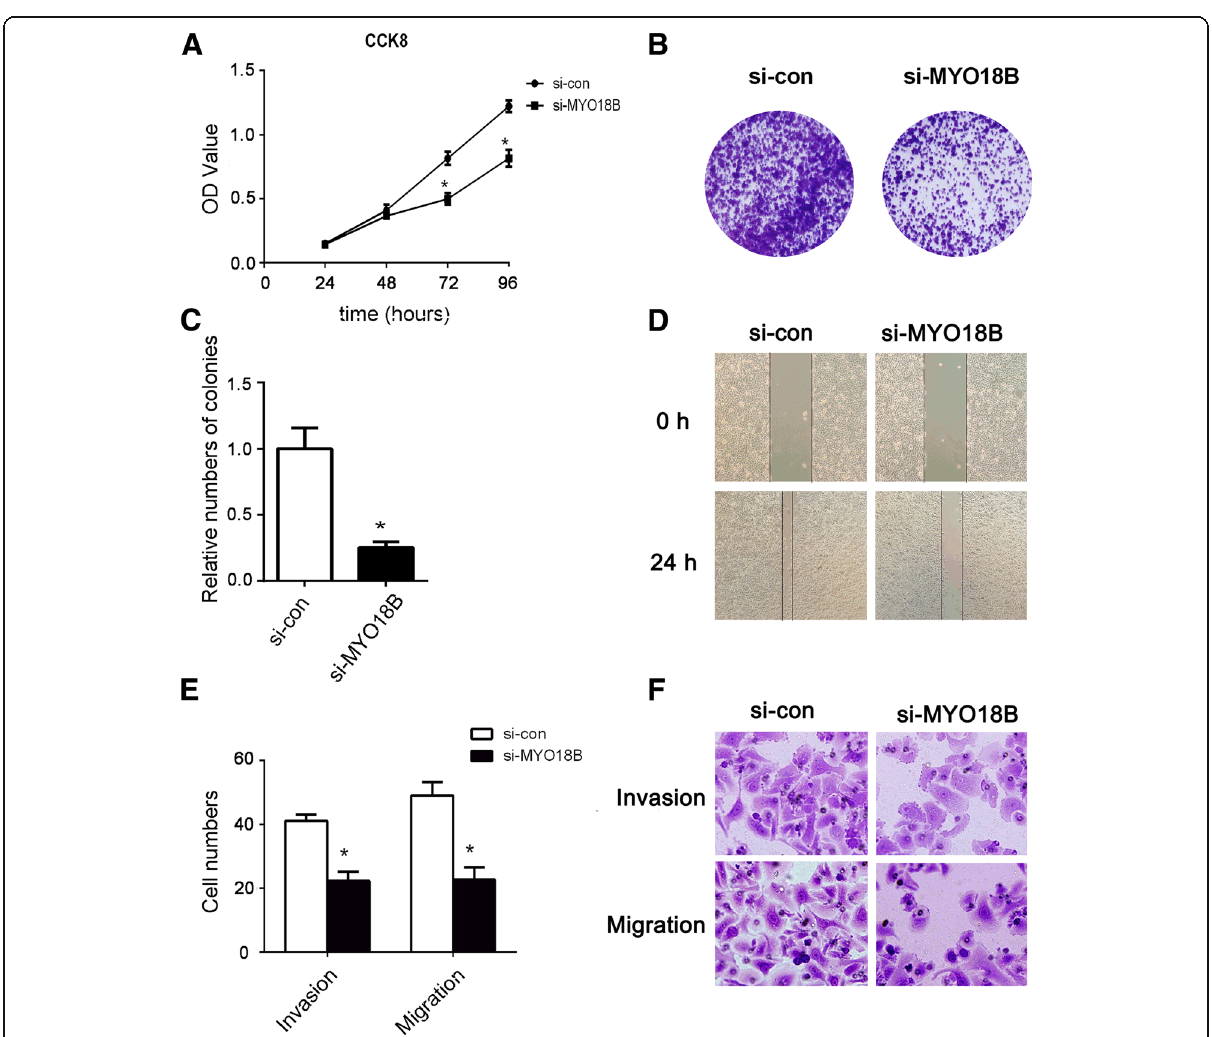
Fig. 3 Knockdown of MYO18B inhibited the proliferation, migration and invasion of HepG2 cells. a CCK-8 assays were performed to measure the proliferation of the transfected HepG2 cells, which showed knockdown of MYO18B (si-MYO18B group) obviously inhibited the cell growth. b , c Colony formation assays were used to determined the proliferation of the transfected HepG2 cells, which also revealed knockdown of MYO18B (si-MYO18B group) obviously inhibited the cell growth. d After incubated the transfected cells for 24 h, knockdown of MYO18B (si-MYO18B group) significantly suppressed the migration of HepG2 cells analyzed by wound healing assays. e , f Transwell assays further demonstrated that knockdown of MYO18B (si-MYO18B group) obviously inhibited the migration and invasion of the transfected HepG2 cells. * P <0.05 versus si-con